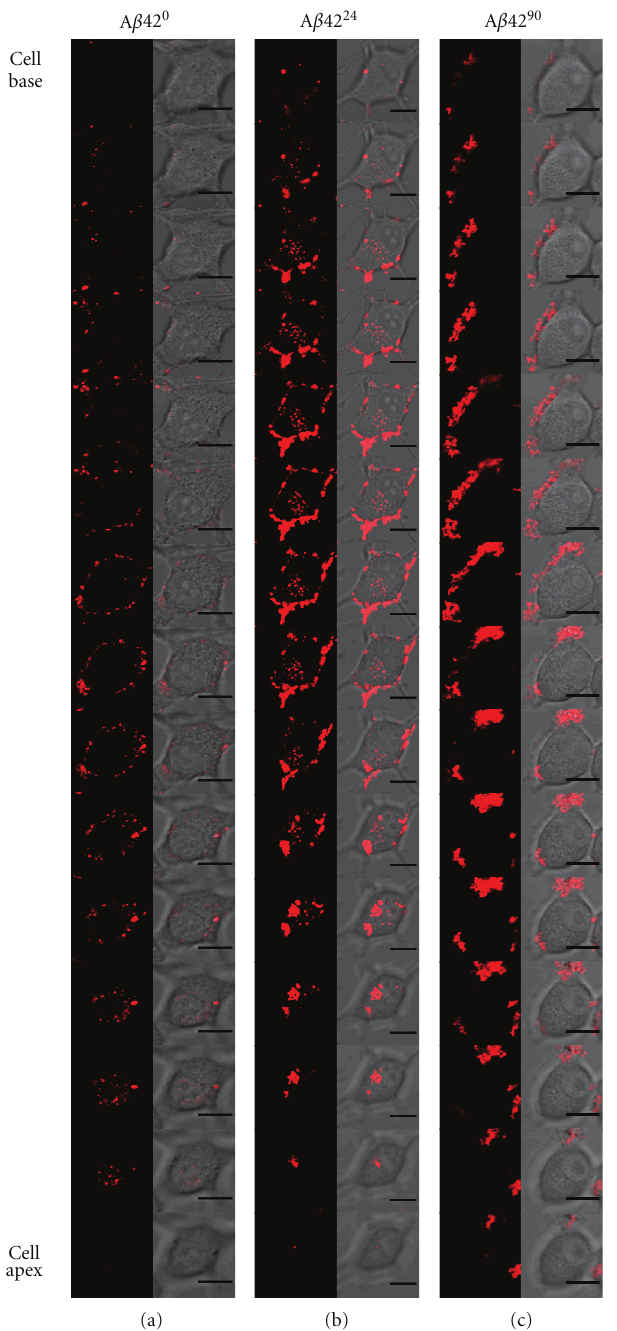
Figure 5: Image planes though a single cell for each A β 42 treatment. Confocal microscopy images from di ff erentiated PC12 cell base to cell apex for A β 42 0 , A β 42 24 , and A β 42 90 , with the TMR signal only (a) and TMR cell merged image (c). All scale bars are 10 μ m in